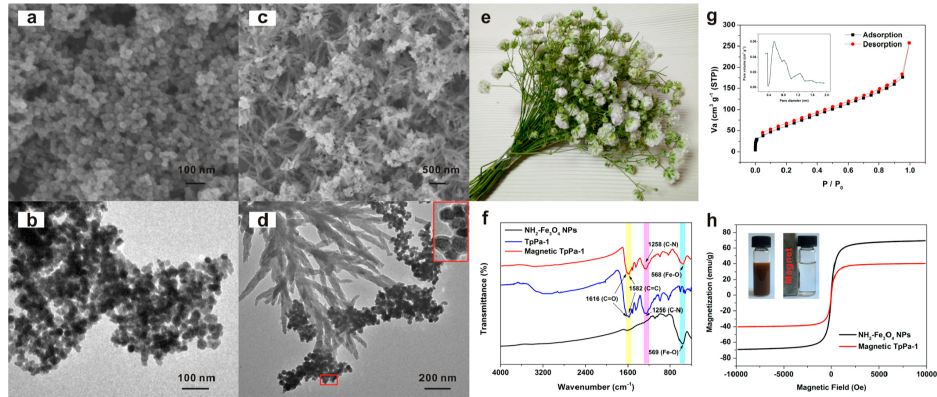
Figure 7. SEM images of the Fe 3 O 4 @NH 2 ( a ) and Fe 3 O 4 @NH 2 @COF ( c ); TEM images of the Fe 3 O 4 @NH